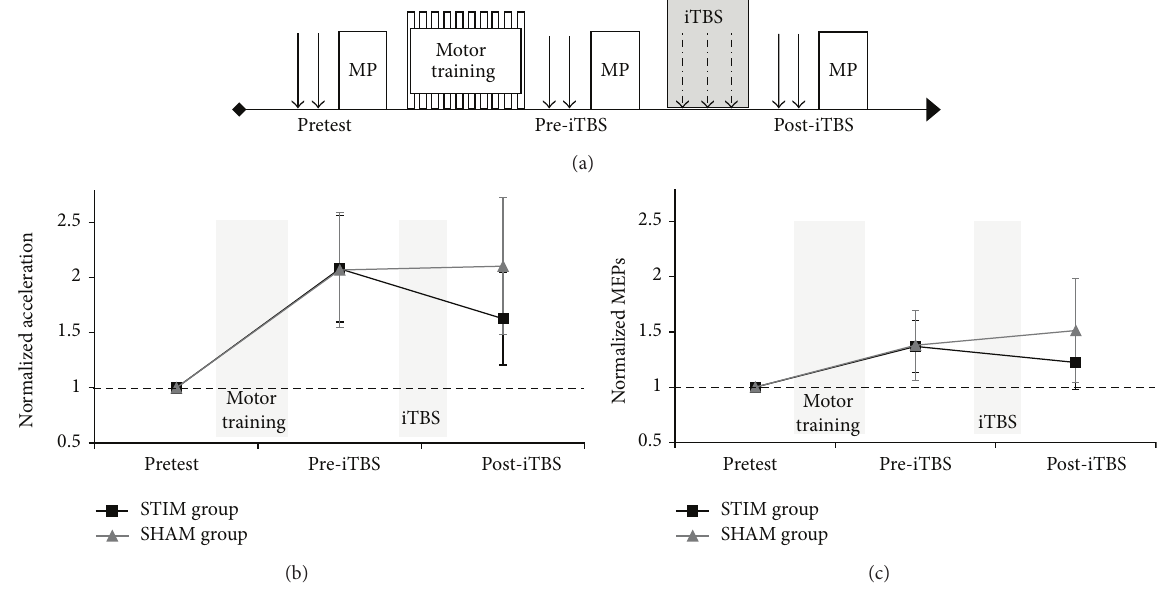
Figure 1: (a) Schematic of the experimental design with assessment of corticospinal excitability (arrows) and motor performance test trials (MP) before motor training (pretest) and before (pre-iTBS) and after iTBS (post-iTBS). Average normalized (b) performance and (c) MEPs of the FDI muscle for the STIM group (black rectangles) and SHAM group (grey triangles). Error bars show 95% confidence intervals (CI) and the horizontal dashed lines represent pretest